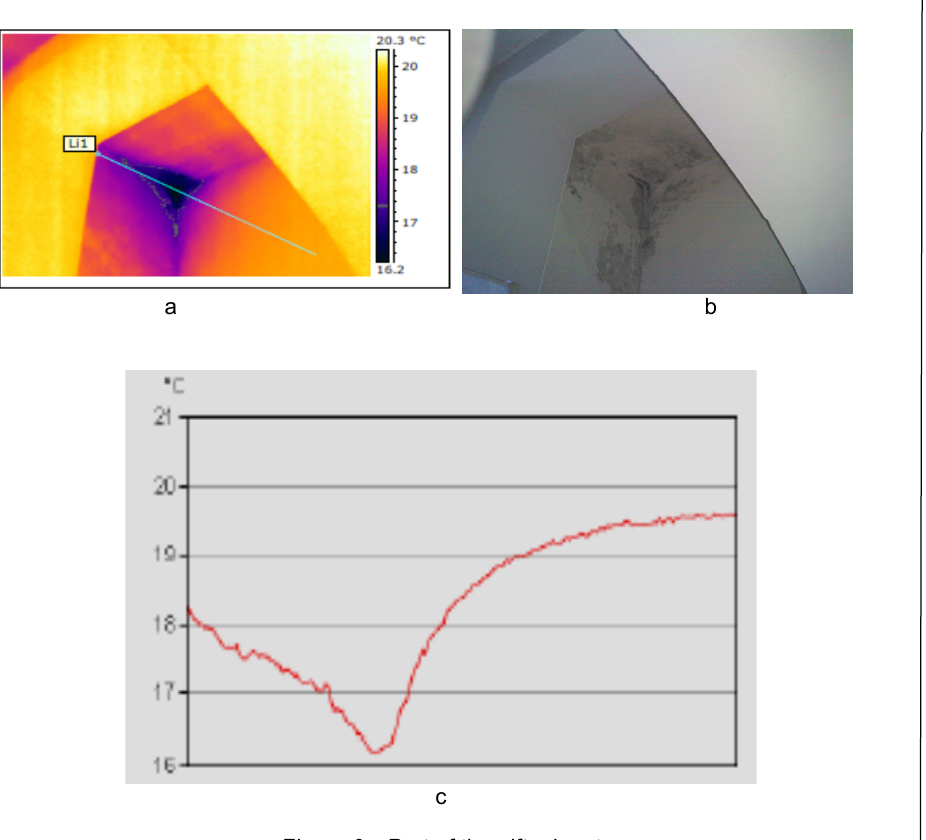
Figure 6 – Part of the gifts